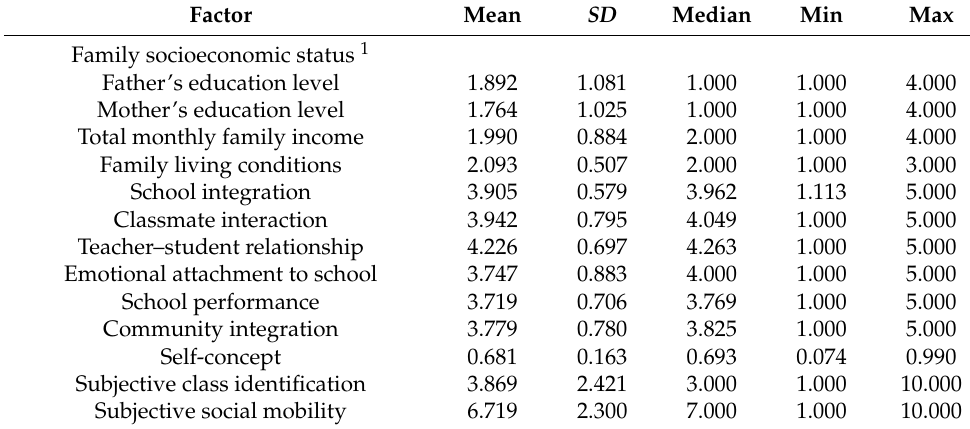
Table 4. Descriptive